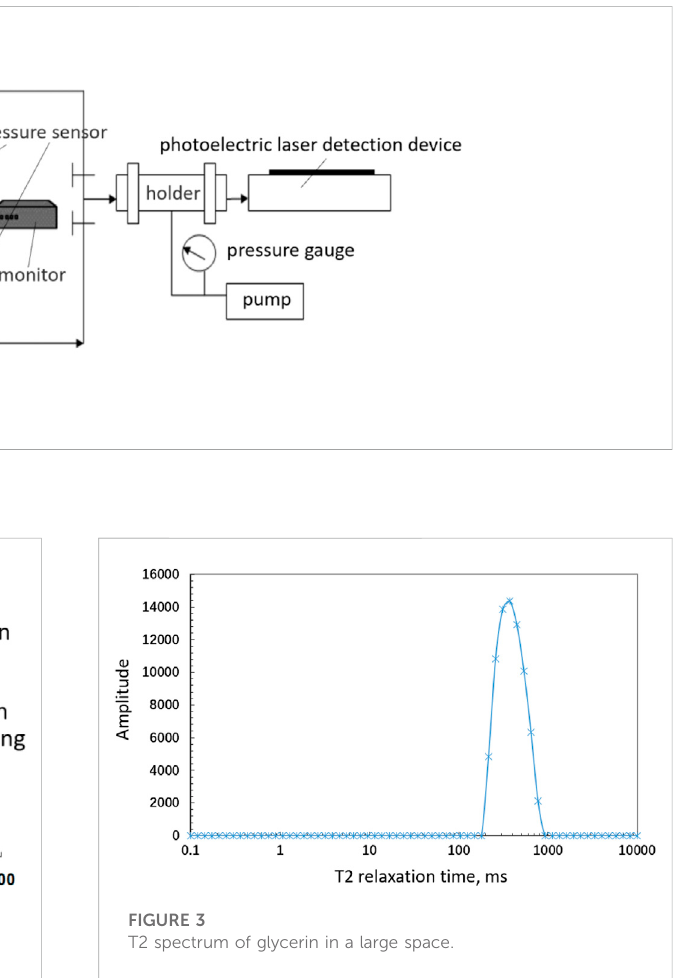
FIGURE 3 T2 spectrum of glycerin in a large